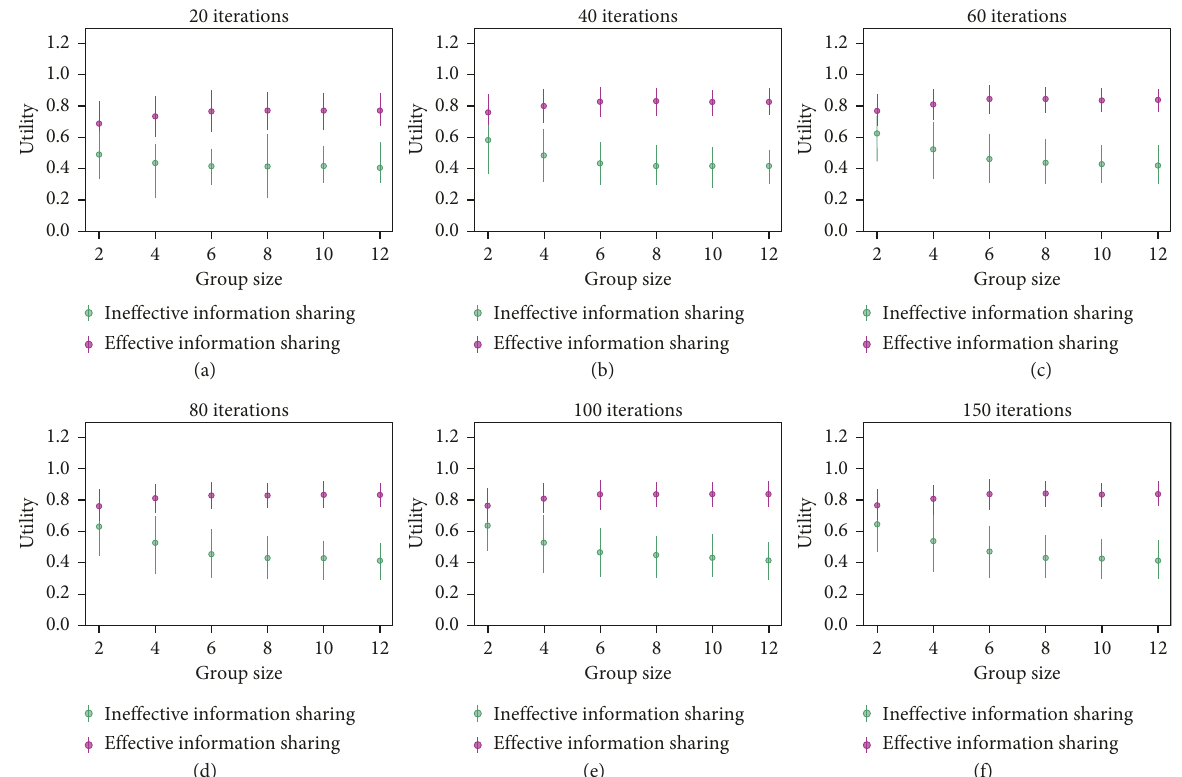
Figure 10: Bar plots regarding the effects of information sharing on group performance for the 15-peak problem